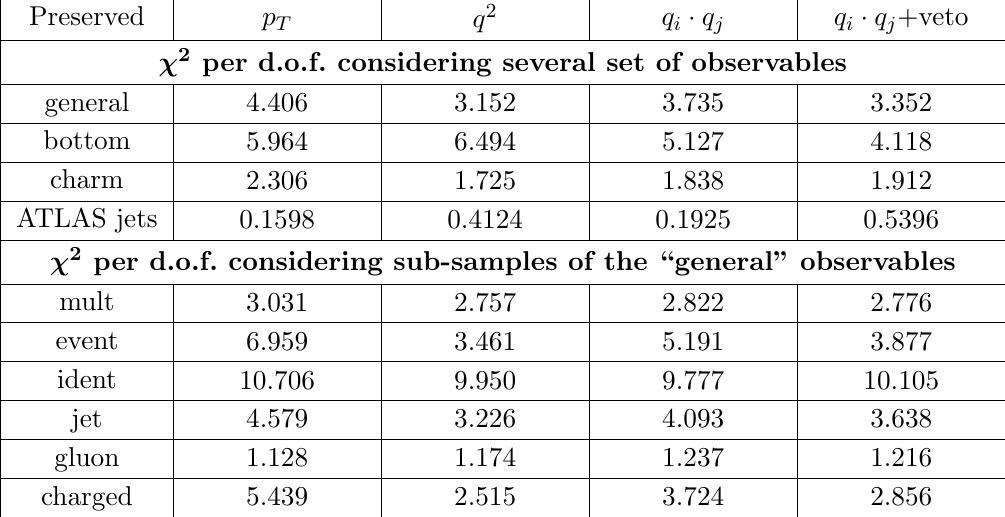
Table 2 . The (cid:31) 2 per degree of freedom for di(cid:11)erent choices of the preserved quantity in the angular-ordered shower, obtained with the distributions we used to tune the light, bottom and charm parameters respectively. The (cid:31) 2 corresponding to ATLAS jets, particle multiplicities (mult), event shapes (event), identi(cid:12)ed-particle spectra (ident), quark jets (jet), gluon jets (gluon) and charged particle distributions (charged) are also shown.